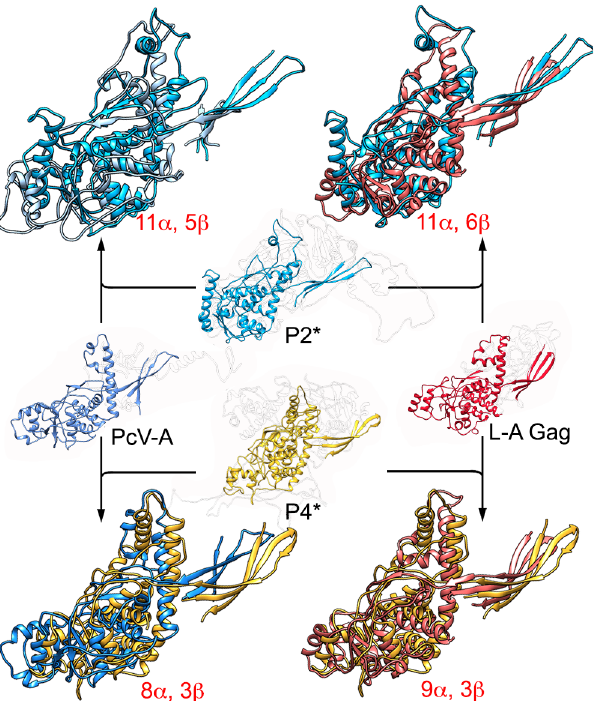
Fig 7. Structural homology of P2 and P4 with PcV CP A domain and L-A virus Gag CP. P2 * and P4 * (center) were structurally alignedwith PcV CP A domain(PcV-A, left) and L-A virus Gag (L-A Gag, right). Center structures indicateconservedSSE within the dsRNA viruses or BTV-like lineage.P2 * is alignedwith PcV-A (blue and light blue, top left) and with L-A Gag (blue and pink, top right). P4 is alignedwith PcV-A (yellowand blue, bottom left) and P4 with L-A Gag (yellowand pink). Total numbersof SSE with close relative spatiallocationsare indicated.